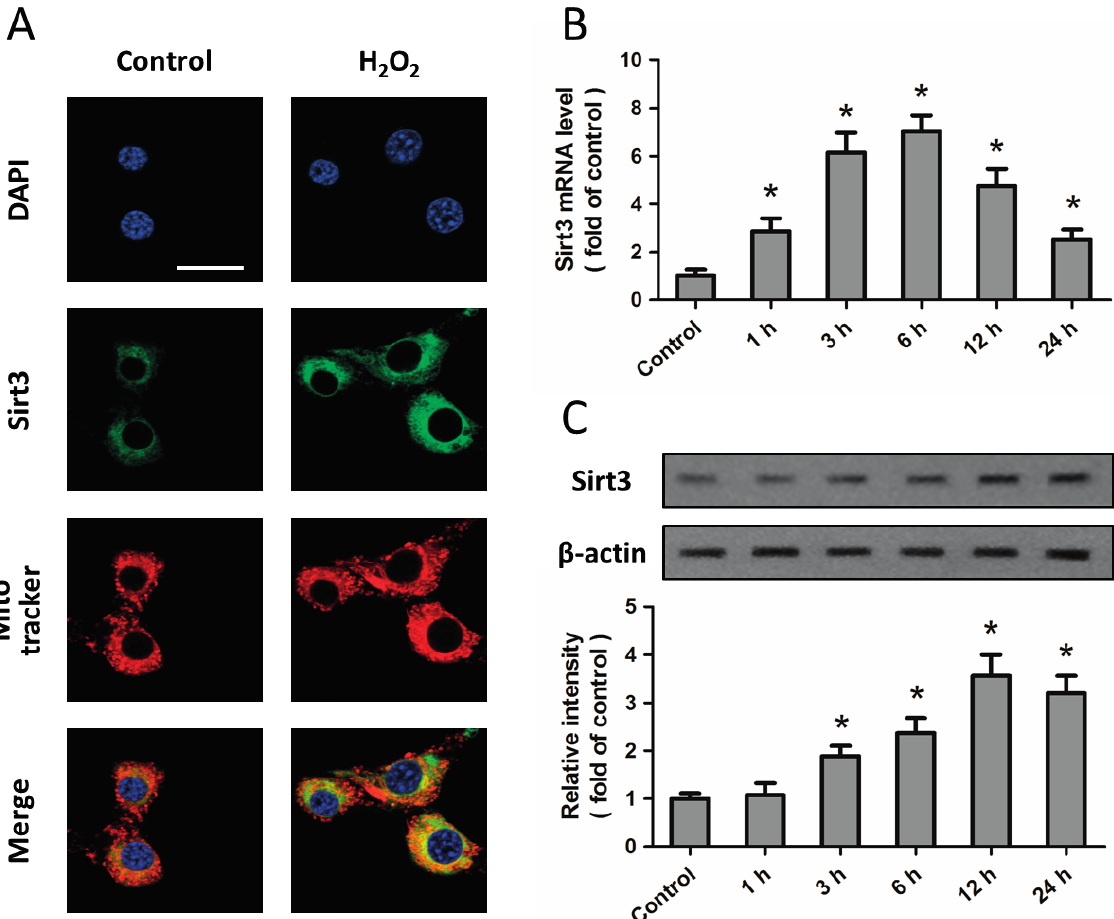
O treatment in cortical neurons. Cortical 2 2 O for 24 h, and the expression and distribution of 2 2